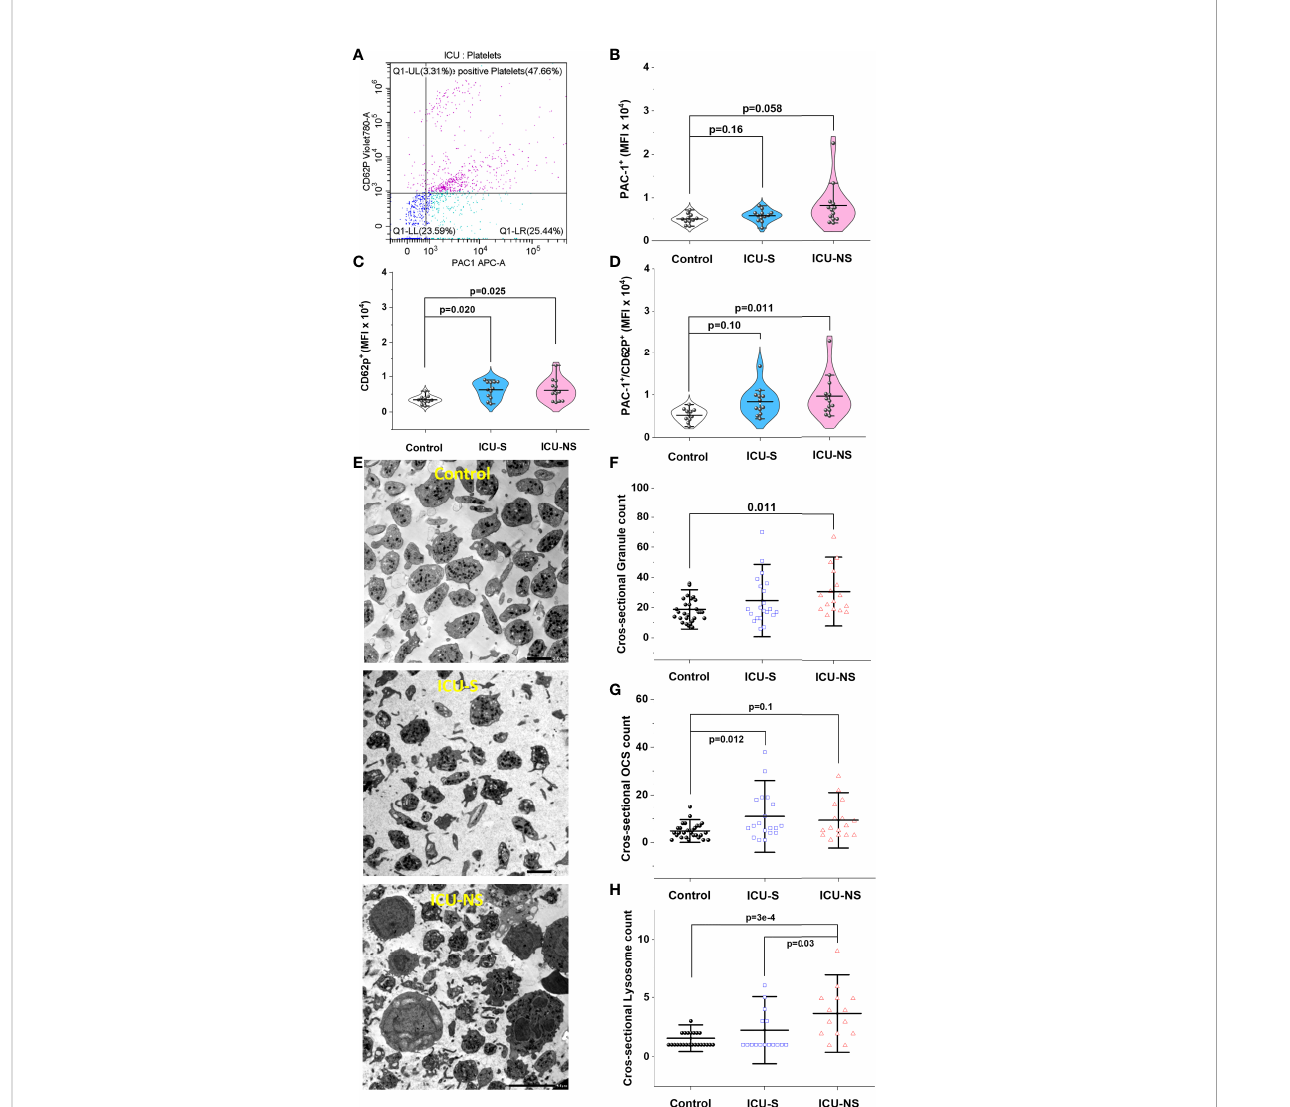
FIGURE 5 Increased platelet activation in severe COVID-19 patients. (A) Representative fl ow cytometric scatter diagram of PAC1 and CD62P double positive populations of platelets for severe patient. (B) A violin plot showing a trend of increase in PAC1 expression in ICU-hospitalized patients relative to control group (n=11, 12, and 13 for control, ICU-S, ICU-NS; respectively). (C) A violin plot showing signi fi cant increase in CD62P mean fl uorescence intensity in both ICU-S and ICU-NS groups when compared to control group (n=11, 12, and 13 for control, ICU-S, ICU-NS; respectively). (D) When the MFI of CD62P/PAC1 were compared for all groups, only platelets of ICU-NS showed signi fi cantly higher MFI of double positive populations when compared to control group (n=11, 12, and 13 for control, ICU-S, ICU-NS; respectively). (E) Representative TEM images for control, ICU-S and ICU-NS groups showing a shift from a resting discoid shape in control subjects to an activated state with numerous pseudopodia in severe COVID-19 patients. (F) A diagram showing a signi fi cant increase in total granule counts ( a - + dense-granules) in ICU-NS group compared to control group (n=3-4 subjects from each group and analyzed platelets = 31, 21, 16 for control, ICU-S, and ICU- NS; respectively). (G) A diagram showing a signi fi cant increase in open canalicular structures (OCS) in the ICU-S group relative to control group (n=3-4 subjects from each group and analyzed platelets = 29, 19, 16 for control, ICU-S, and ICU-NS; respectively). (H) A diagram showing signi fi cantly increased count of lysosomes per platelet of the ICU-NS group relative to control and ICU-S groups (n=3-4 of each group and analyzed platelets = 27, 17, 14 for control, ICU-S, and ICU-NS; respectively). Multiple comparisons were carried out using ANOVA followed by Tukey test and p values are given. Data plotted as mean ±